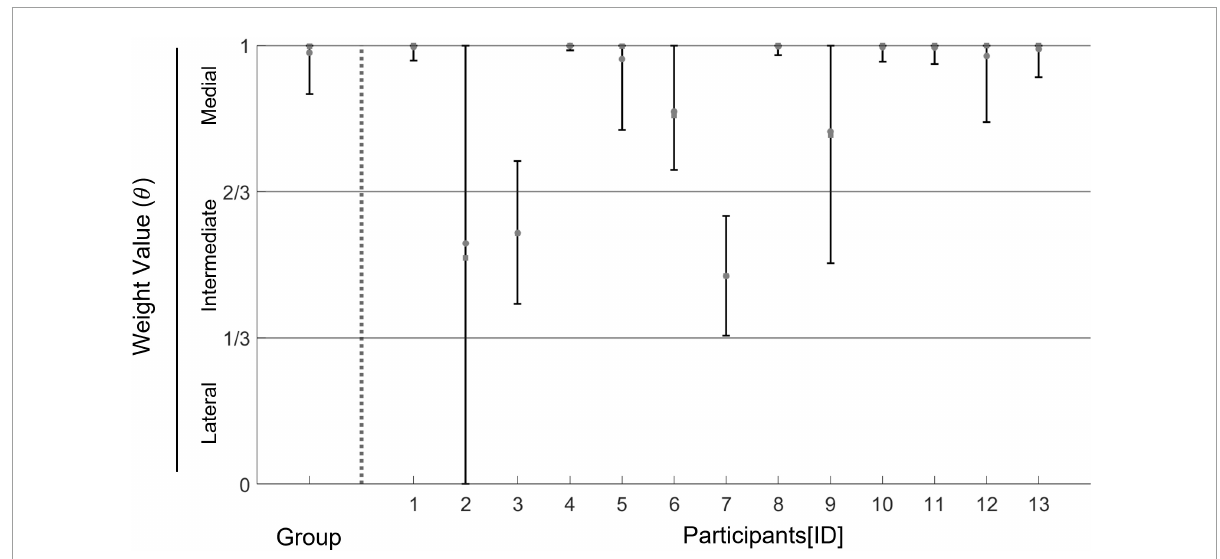
FIGURE5 Estimated values of a group weight and individual weights between the policies of medial stepping and lateral stepping estimated in the dual-target condition. Round dots represent a posterior mean of the value of weight between the medial stepping and the lateral stepping for each participant. Square dots represent a posterior median of the same parameter for each participant. Error bars represent a 95% creditable interval of each estimated parameter. Horizontal lines represent 1/3 and 2/3, respectively. These lines are the interest value for judging whether the COP pattern for each participant is either a “medial weighing pattern”, a “lateral weighing pattern”, or an “intermediate weighting pattern”.